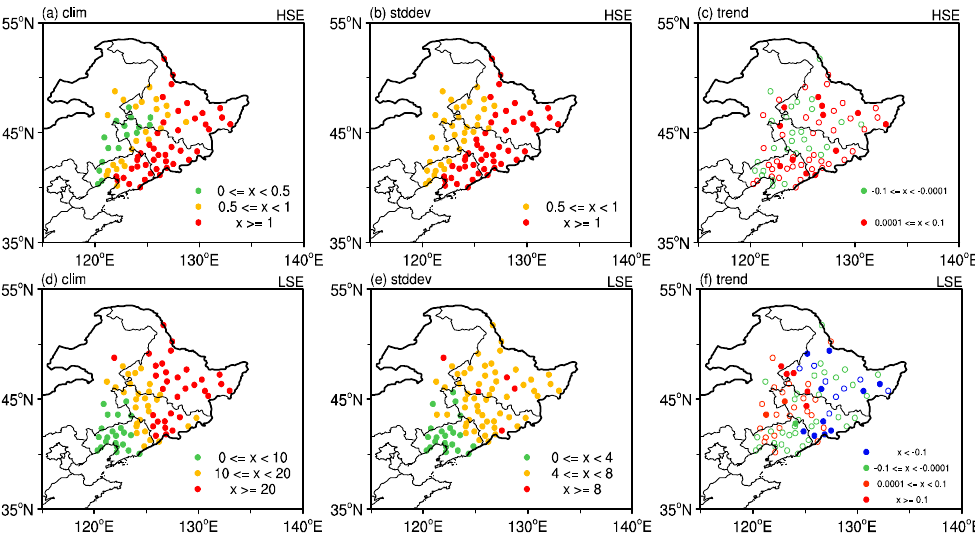
Figure 1. Climatological spatial distributions of wintertime heavy snowfall event (HSE) and light snowfall event (LSE) in northeast China (NEC) during 1961–2017: ( a – c ) HSE climatology (units: day), standard deviation (units: day), and linear trend (units: day (10 a) − 1 ), respectively; ( d – f ) as in ( a – c ) but for LSE. In ( c , f ), filled dots are above the 90% confidence level.